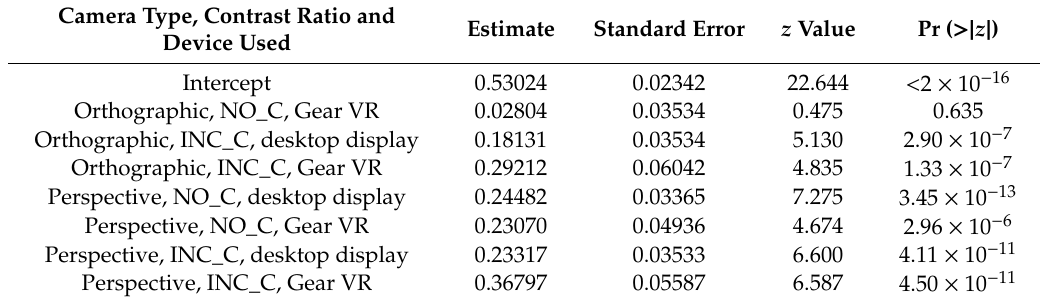
Table 33. Logistic regression analysis results of the e ff ects of the camera type, contrast ratio, and device used.